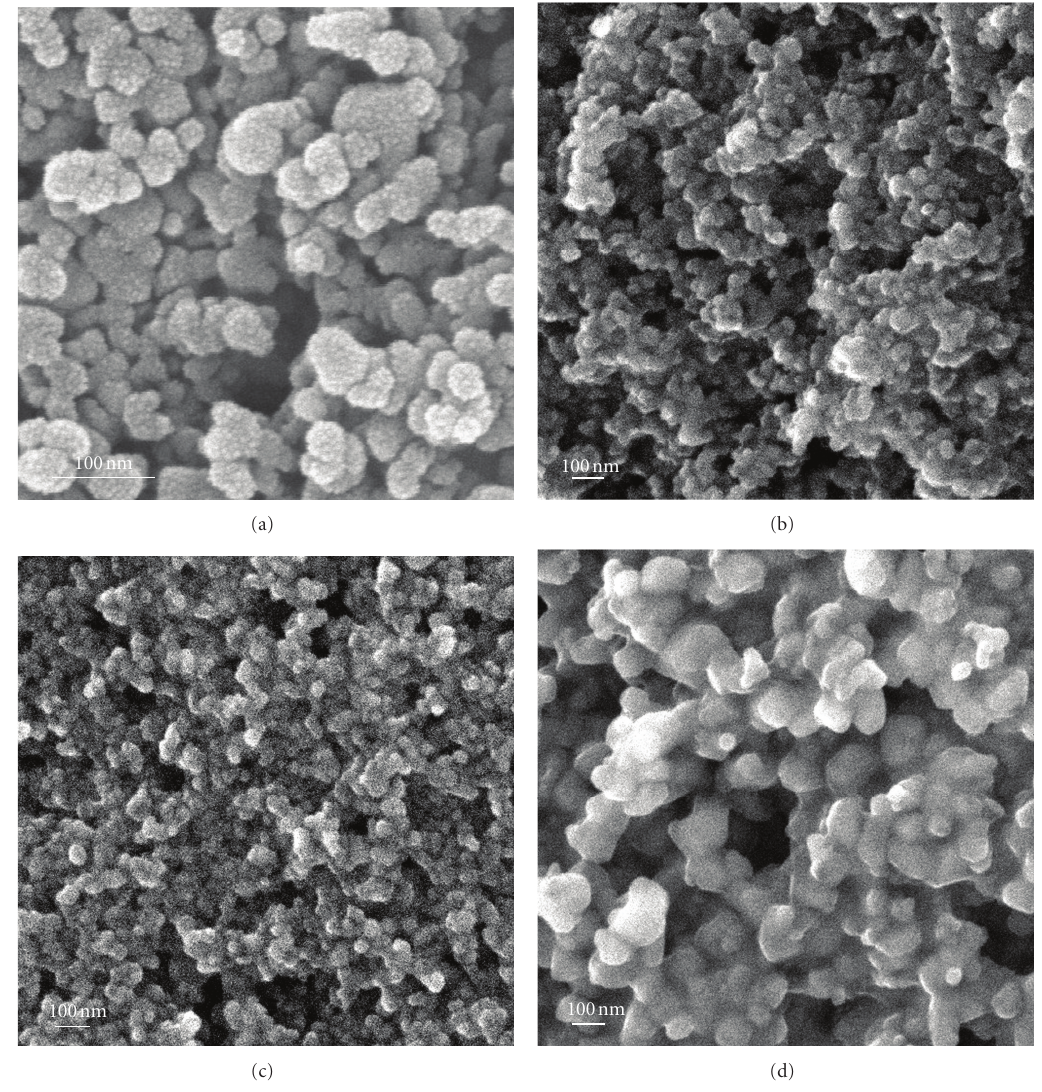
Figure 7: SEM images of the P25 powders before (a) and after calcined at 400 (b), 500 (c), and 700 ◦ C (d) for